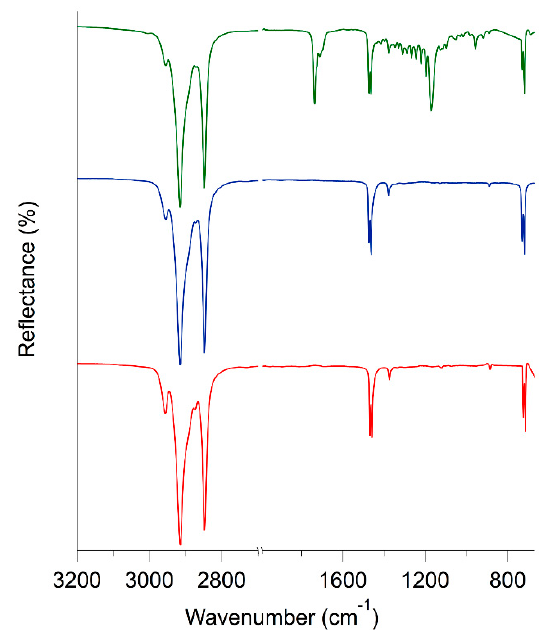
Figure 2. FTIR-ATR spectra of three selected waxes: beeswax (green), paraffin (blue) and ceresin (red).